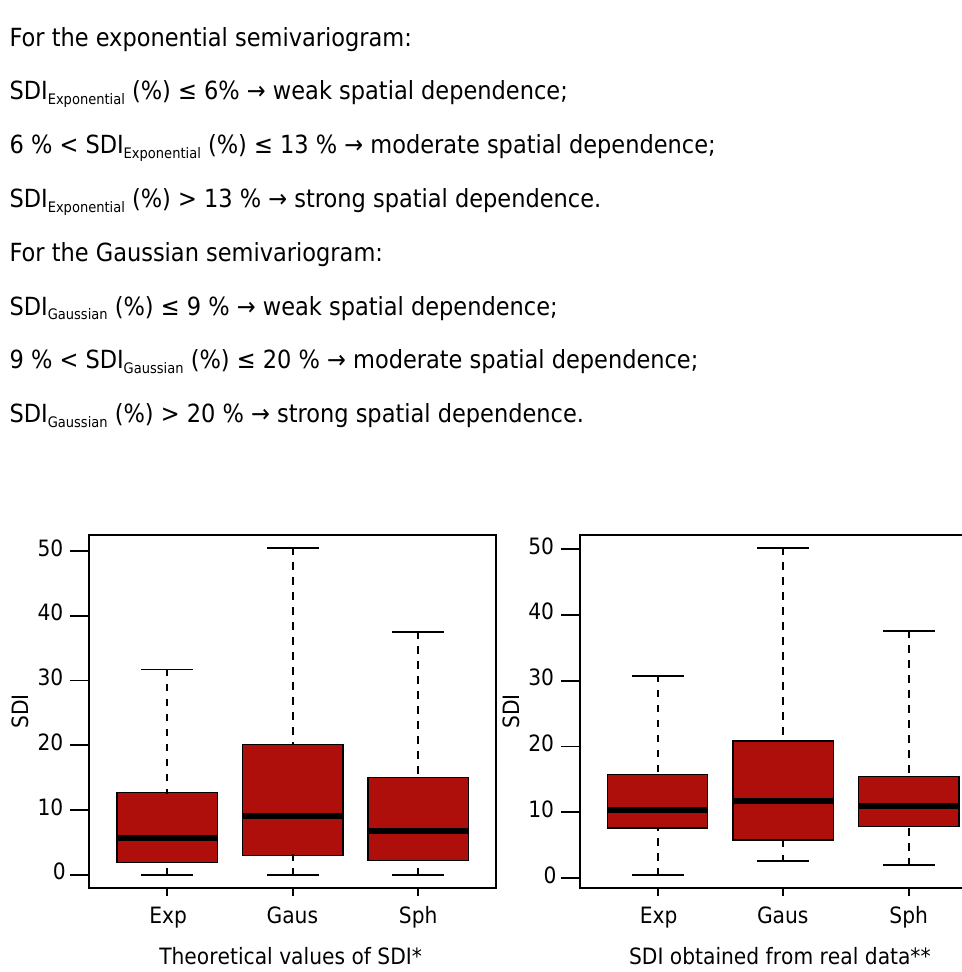
Figure 1. Boxplot graphs of the distribution of the theoretical values of the spatial dependence index (SDI) and boxplot graphs of the distribution of the SDI obtained from real data, for the exponential model (Exp), Gaussian model (Gaus), and spherical model (Sph). * (n = 169). Exp: minimum = 0.0, 1st quartile = 1.9, median = 5.7, 3rd quartile = 12.7, maximum = 31.7; Gaus: minimum = 0.0, 1st quartile = 3.0, median = 9.1, 3rd quartile = 20.2, maximum = 50.4; Sph: minimum = 0.0, 1st quartile = 2.3, median = 6.8, 3rd quartile = 15.0, maximum = 37.5; ** (n = 109). Exp: minimum = 0.5, 1st quartile = 7.6, median = 10.4, 3rd quartile = 15.8, maximum = 30.8, n = 112; Gaus: minimum = 2.6, 1st quartile = 5.8, median = 11.7, 3rd quartile = 20.7, maximum = 50.1, n = 110; Sph: minimum = 2.0, 1st quartile = 7.9, median = 11.0, 3rd quartile = 15.4, maximum =